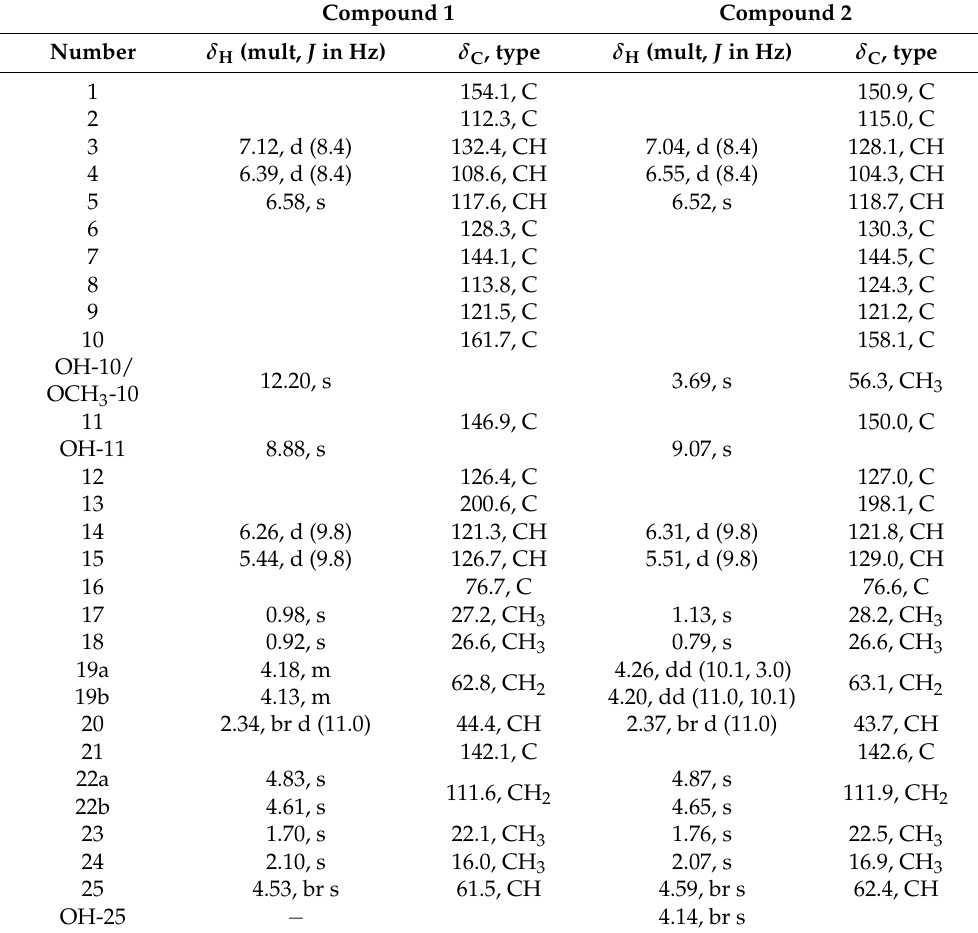
Table 1. 1 H (500 MHz) and 13 C-NMR (125 MHz) data of compounds 1 and 2 in DMSO- d 6 Compound 1 Compound